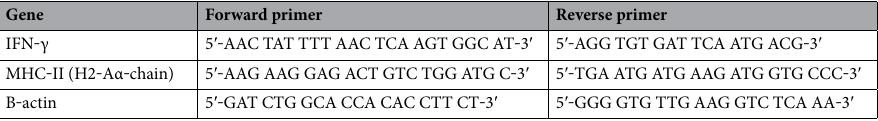
Blood samples were clotted on ice, then cells were centrifuged (13.3 K RPM for 10 min at room temperature) and supernatant was removed. Pellets were then lysed with 1 ml of RBC lysis buffer (Sigma Aldrich, St. Louis, MO) for 5 min. After a second centrifugation, supernatant was removed and samples were transferred to v-bottom flow plates using 100 μl of media (Greiner Bio-One GmbH, Kremsmuenster, Austria). Single-cell suspensions of peripheral (superficial cervical, axillary, mediastinal, brachial, and inguinal) lymph nodes (LN) and/or spleen were cultured under varied conditions as indicated in text. For cohort 1 & 2, cells were stained with the following monoclonal antibodies for flow cytometric analysis: anti-CD4-Pacific Blue (RM4-5; BD Pharmingen, San Diego, CA), -APC, -PE, and -FITC (GK1.5; eBioscience, San Diego, CA); anti-CD8α-Alexa Fluor 700 (RPA-T8), -FITC and -PE (53-6.7; BD Pharmingen); anti-CD25-APC (PC61.5; BD Pharmingen), -PE and -Alexa Fluor 700 (53-6.7; eBioscience); anti-CD44-PE (IM7; BioLegend, San Diego, CA); anti-CD69-APC